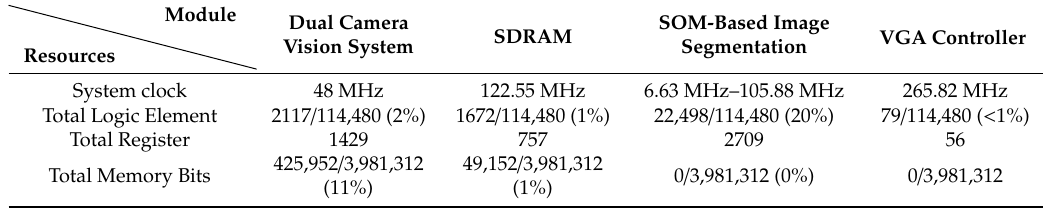
Table 3. Resource allocation of the proposed stereo vision system on an altera cyclon IV chip.